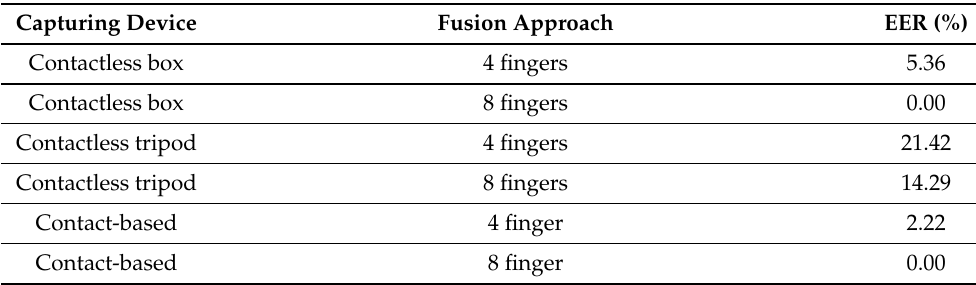
Table 6. Overview of the EER in a fingerprint fusion approach: Fusion over the 4 inner-hand fingers of the left hand (IDs 2–4) and right hand (IDs 7–10) fusing and fusion over 8 fingers of both inner hands (IDs: 2–4,